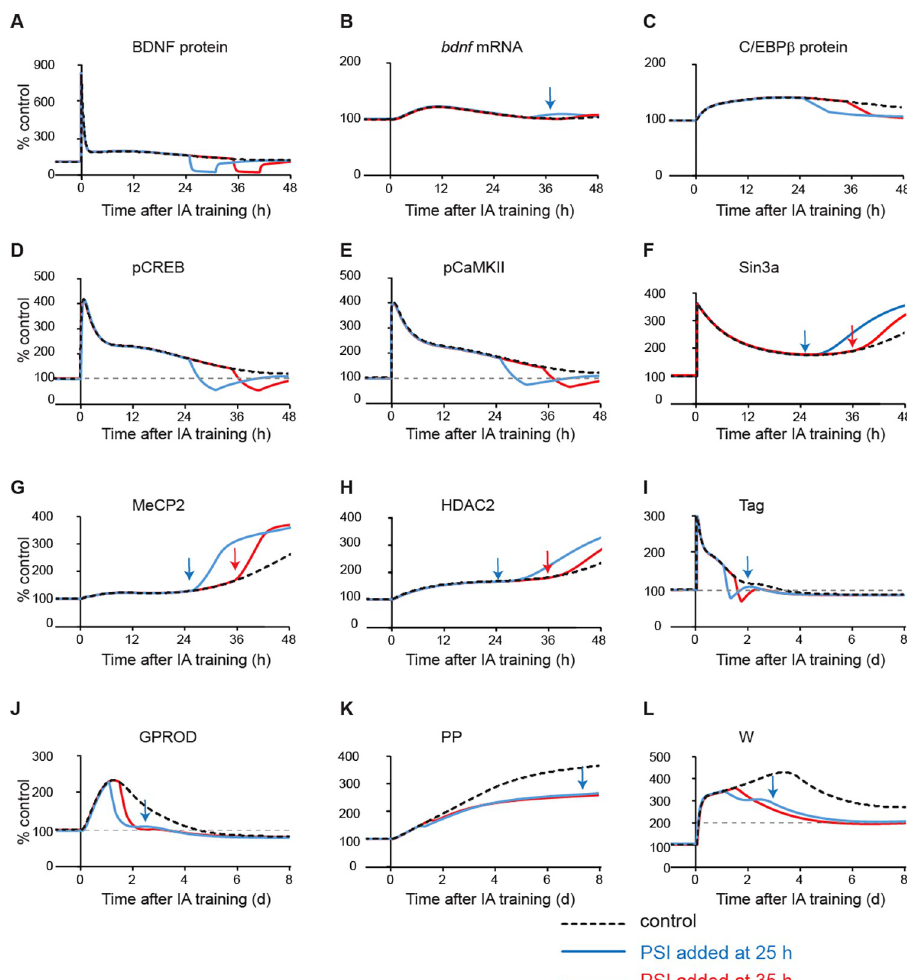
Fig 4. Simulated dynamics of model variables when PSI was added 25 h or 35 h post-stimulus. Example of dynamics of BDNF protein/mRNA (A-B), C/EBP β protein (C), pCREB (D), pCaMKII α (E), and Sin3a binding (F), MeCP2 binding (G), HDAC2 binding (H), Tag (I), GROD (J), PP (K), and W (L), without PSI (black dashed) or with PSI added at 25 h post- stimulus (blue), or at 35 h post- stimulus (red). of W reduction with respect to the time of PSI initiation during the second phase (Fig 4). We selected the time points of 25 h and 35 h post stimulus because these two time points are the beginning and end of the second phase (Fig 3B). Here we investigated why W at day 7 with PSI added at 25 h was greater than W with PSI added at 35 h, (i.e., the reduction of W by PSI applied at 25 h was less than the reduction of W by PSI applied at 35 h). With PSI added 25 or 35 h post stimulus, BDNF decreased in both cases, leading to a decrease in pCaMKII α (Fig 4A and 4E, blue vs . red vs . black dashed curves), releasing its inhibitory effect on MeCP2 binding (Fig 4G, blue vs . red vs . black dashed curves). However, when PSI was added at 25 h, MeCP2 binding quickly increased (Fig 4G, blue arrow), faster than the increase of Sin3a and HDAC2 binding which remained low for several hours before their increase (Fig 4F and 4H, blue arrows). Thus, MeCP2 alone bound to bdnf exon IV promoter to increase the expression of bdnf , before Sin3a and HDAC2 could bind it to form the inhibitory complex. The increase in bdnf expression occurred after PSI was removed, due to the increased binding of MeCP2 alone